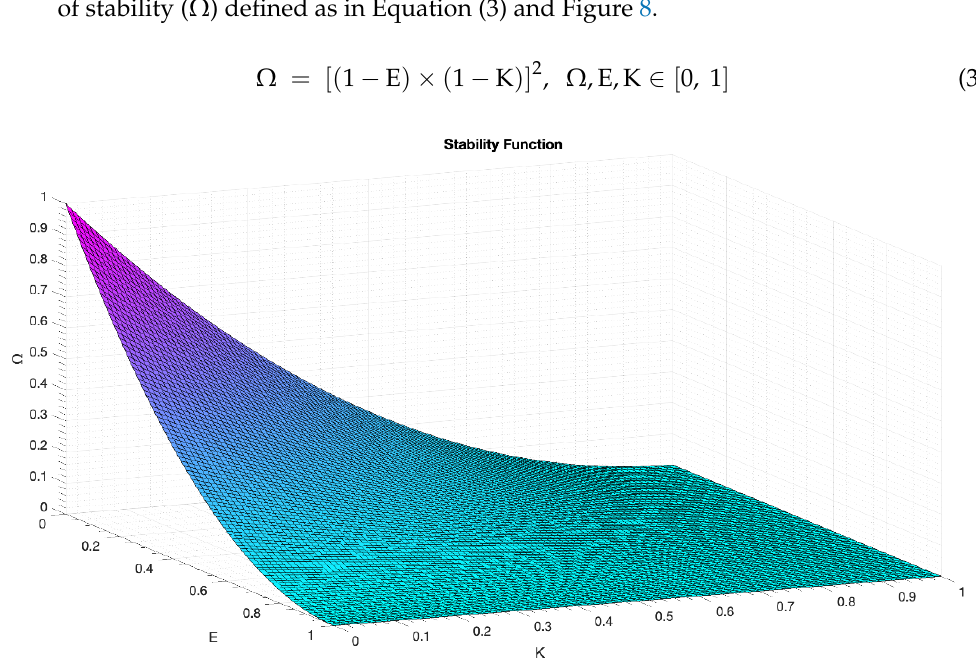
Figure 8. 3D plot of the stability function.